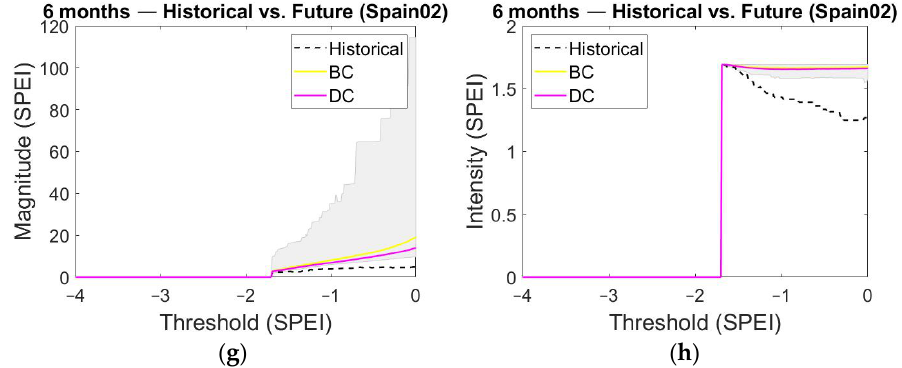
Figure A1. Historical and future meteorological drought ( a ) frequency; ( b ) mean duration; ( c ) mean magnitude; ( d ) mean intensity derived from SPI for the 6 months temporal-aggregation scale (Spain02 database). Historical and future meteorological drought ( e ) frequency; ( f ) mean duration; ( g ) mean magnitude; ( h ) mean intensity derived from SPEI for the 6 months temporal-aggregation scale (Spain02 database).